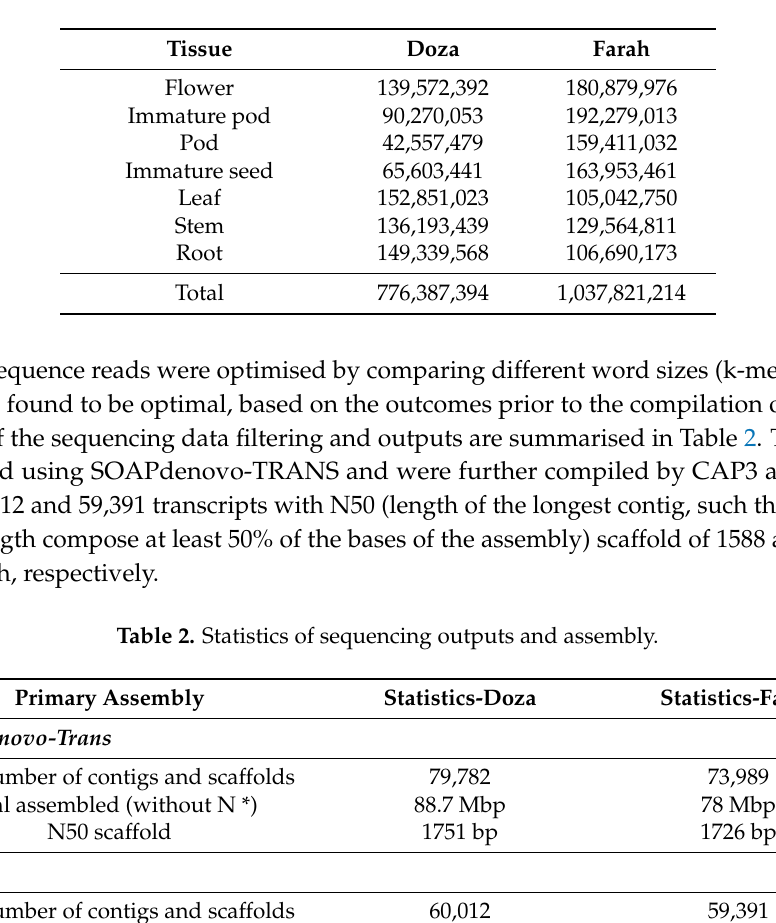
Table 1. Summary details of the reads (paired-end) used for de novo transcriptome assembly.